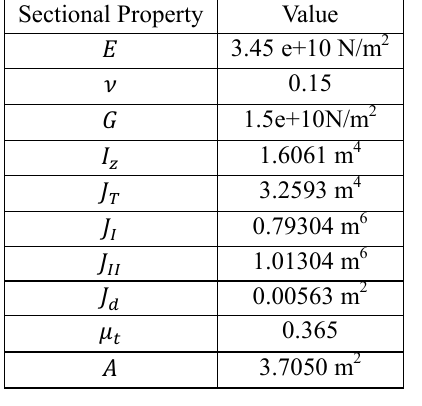
Different sectional properties.